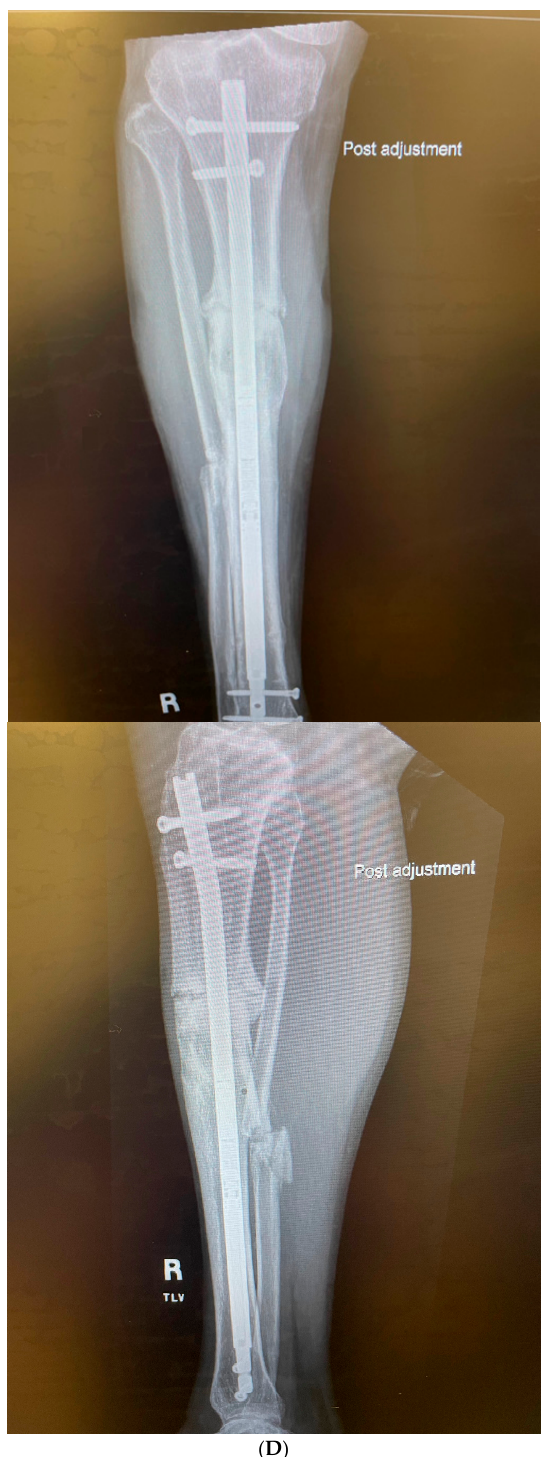
Figure 8. (A) Adult male with varus malunion deformity after a prior tibia fracture and nailing. ( B , C ) Patient underwent focal dome osteotomy with compression nailing using a magnetic motorized nail for early and subsequent nail compression. ( D ) Patient declined to follow-up after 12 weeks, citing absence of pain. Patient returned at 6 months at request of surgeon, still without pain. Magnetic nail recompressed. Patient lost to follow ‐ up after 6 months